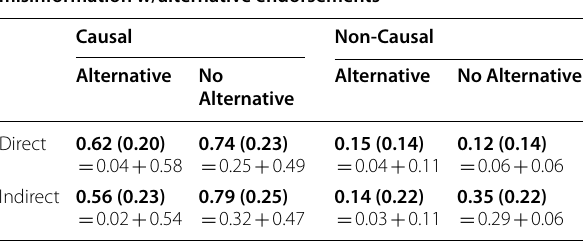
Table 9 Means (standard deviations) of total misinformation proportion for all Experiment 2